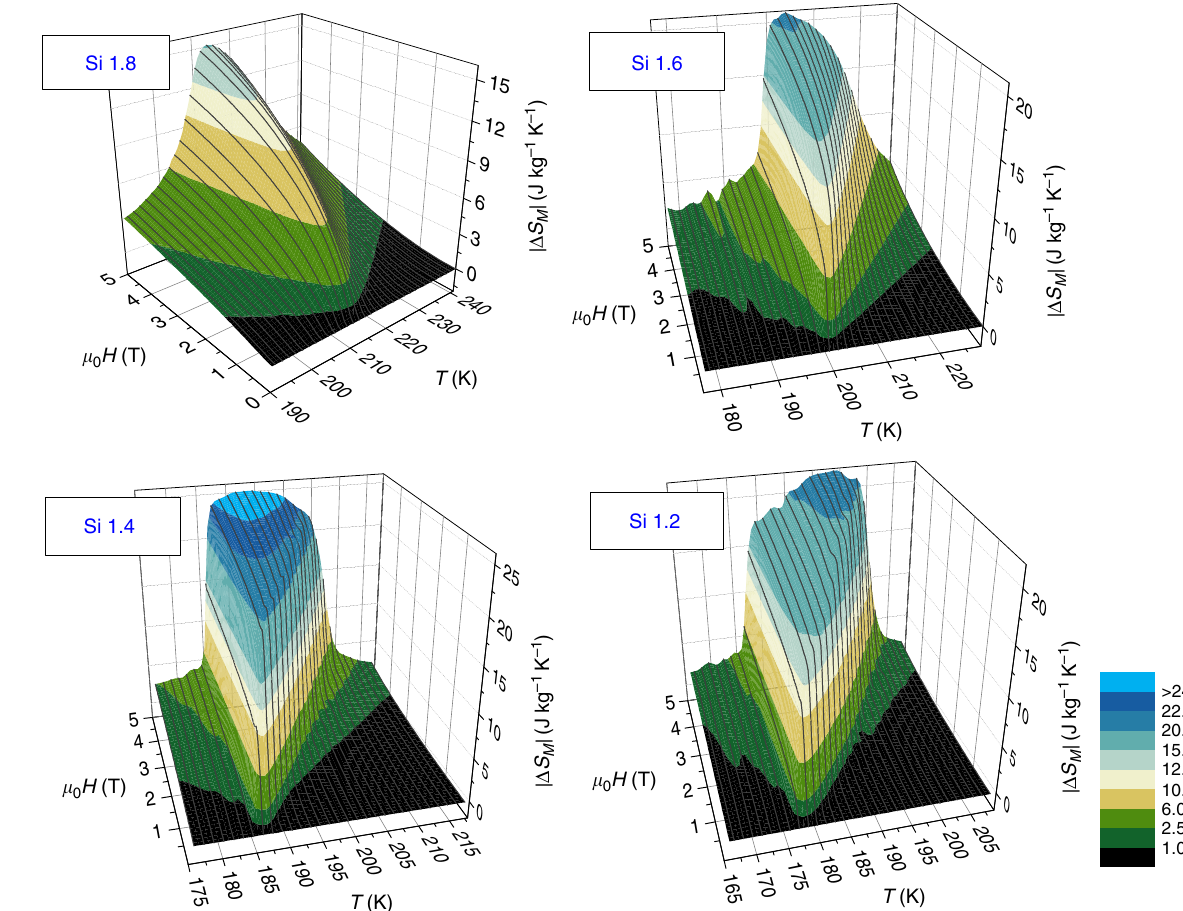
Fig. 3 Magnetic entropy change of the studied La 1 Fe 13- x Si x alloys. While Si 1.8 exhibits “ caret ” type behavior, Si 1.4 and Si 1.2 have the shape of a “ cliff ” . Si 1.6 apparently exhibits one behavior or the other, depending if we look at the low or high temperature parts of the